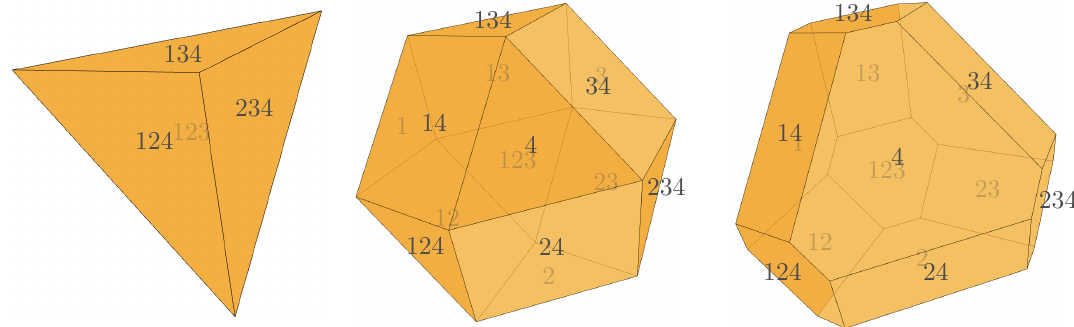
Figure 6. From left to right: polytopes U to the corresponding subdiagram γ ⊂ B 4